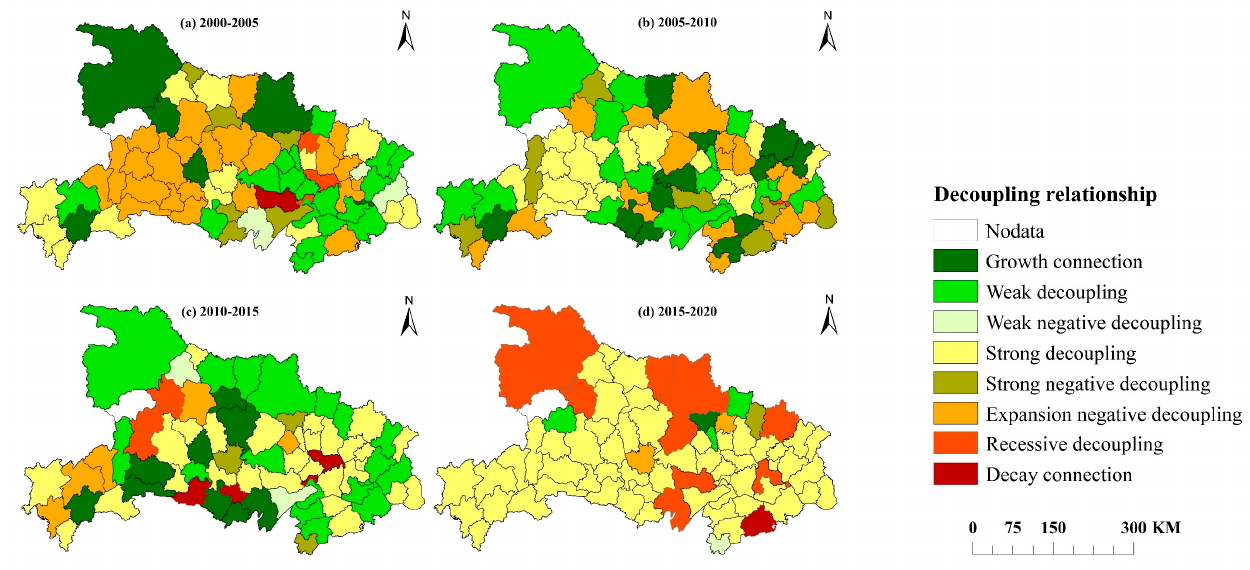
Figure 9. Decoupling characteristics between carbon emissions and agricultural economic growth in Hubei Province (Four stages).